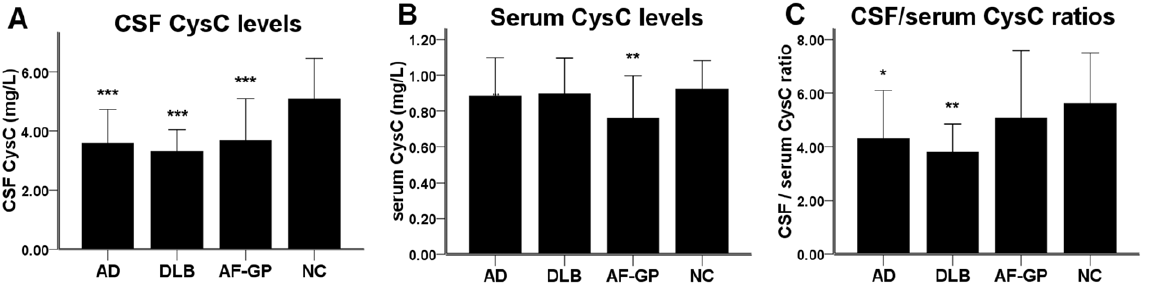
Figure 1. The CSF and serum CysC levels in AD, DLB, AF-GP and normal control subjects. (A) The levels of CSF CysC were significantly lower in patients with AD, DLB and AF-GP compared to normal controls. (B) The levels of serum CysC were significantly lower in patients with AF-GP compared to normal controls. (C) The CSF/serum CysC ratios were significantly lower in patients with AD and DLB compared to normal controls. Statistically significant difference was calculated using one-way ANOVA, followed by Bonferroni’s post hoc test. Data are means 6 SD. Abbreviations: CysC, cystatin C; AD, Alzheimer’s disease; DLB, dementia with Lewy body; AF-GP, the atrophic form of general paresis; NC, normal control. (*p , 0.05, **p , 0.01, ***p , 0.001).